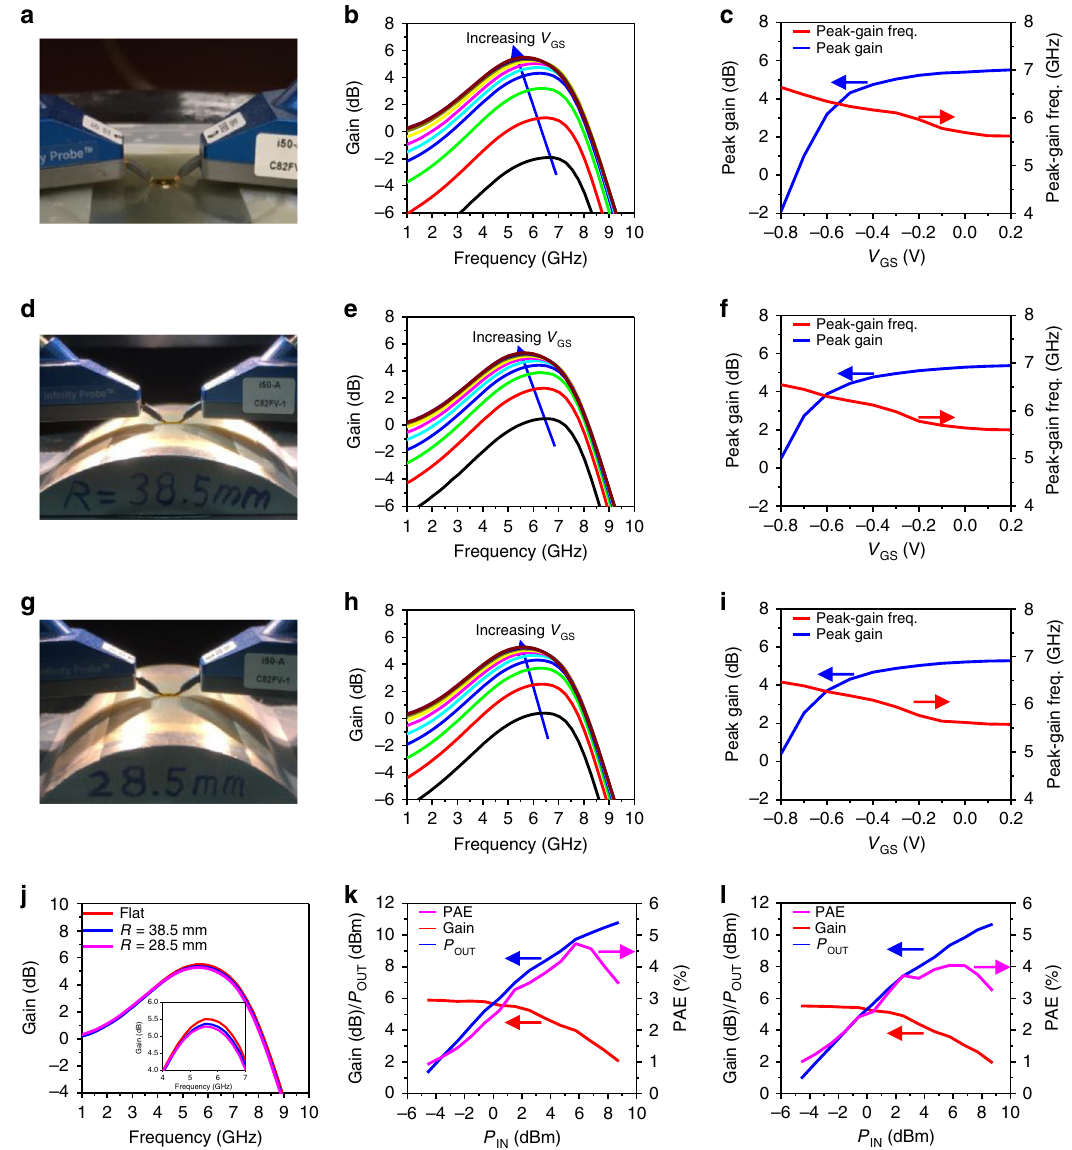
Fig. 5 Microwave characterizations of ampli fi er on CNF substrate. a , d , g Photographs of an ampli fi er during microwave characterizations under fl at ( a ) and bent conditions ( d , R = 38.5 mm; g , R = 28.5 mm). b , e , h Measured small-signal gain values of the ampli fi er as a function of frequency under fl at ( b ) and bent conditions ( e , R = 38.5 mm; h , R = 28.5 mm). During the measurements, V DS of the HEMT in the ampli fi er was set at 10 V and V GS was swept from − 0.8 V to 0.2 V with a step size of 0.1 V. c , f , i Plots of peak small-signal gain values and the corresponding frequencies as a function of V GS of the ampli fi er under fl at ( c ) and bent conditions ( f , R = 38.5 mm; i , R = 28.5 mm). j Comparison of the measured peak small-signal gain values (i.e., under V DS = 10 V and V = 0.2 V) under fl at and bent conditions. The inset shows the magni fi ed view of the curves from 5 GHz to 6 GHz. k , l Measured P GS and PAE as functions of P IN of the ampli fi er under fl at ( k ) and bent condition ( i , R = 38.5 mm) under continuous-wave operation